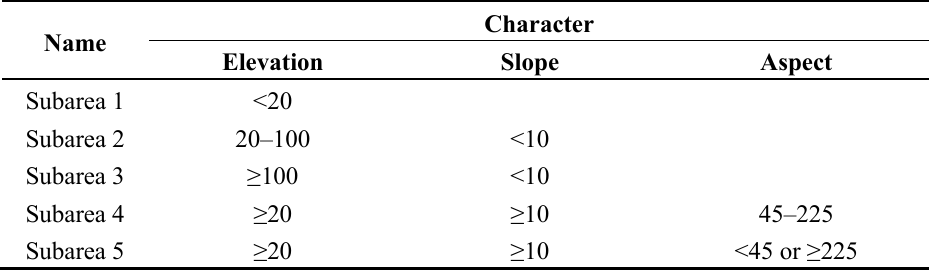
Table 3. Spatial division for vegetation